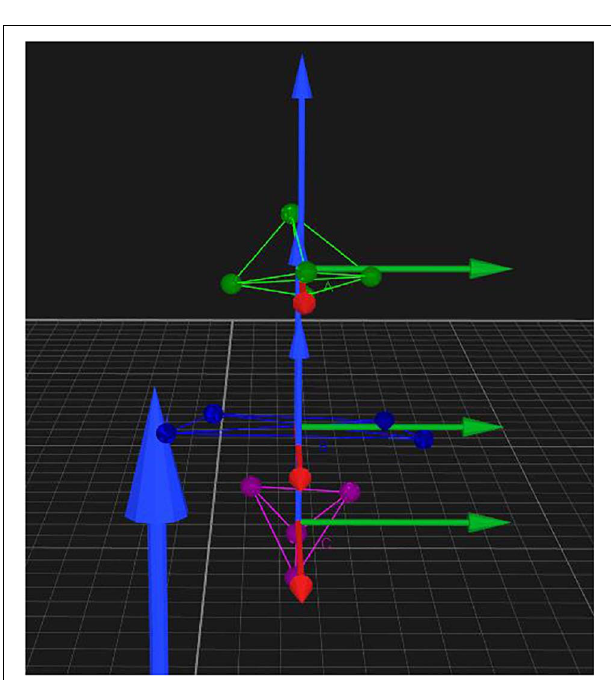
FIGURE 2 | Position of markers displayed in the motion capture system and the relationship and coordinate system between the head rigid body and the torso rigid